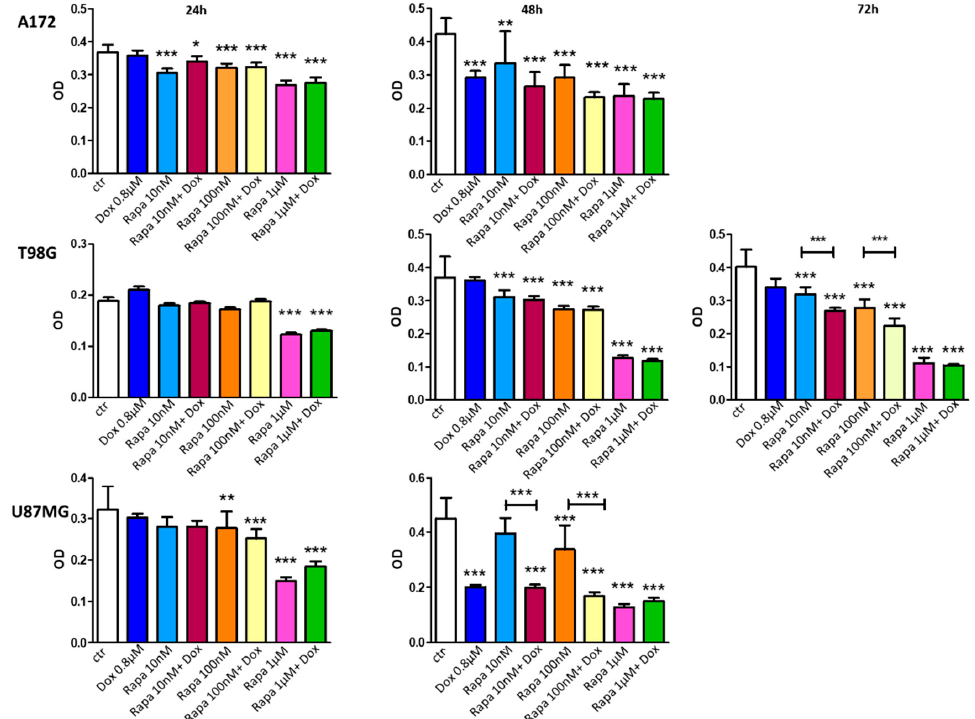
Figure 1. Effect of Dox, Rapa and their combinations on human glioblastoma (GBM) cell